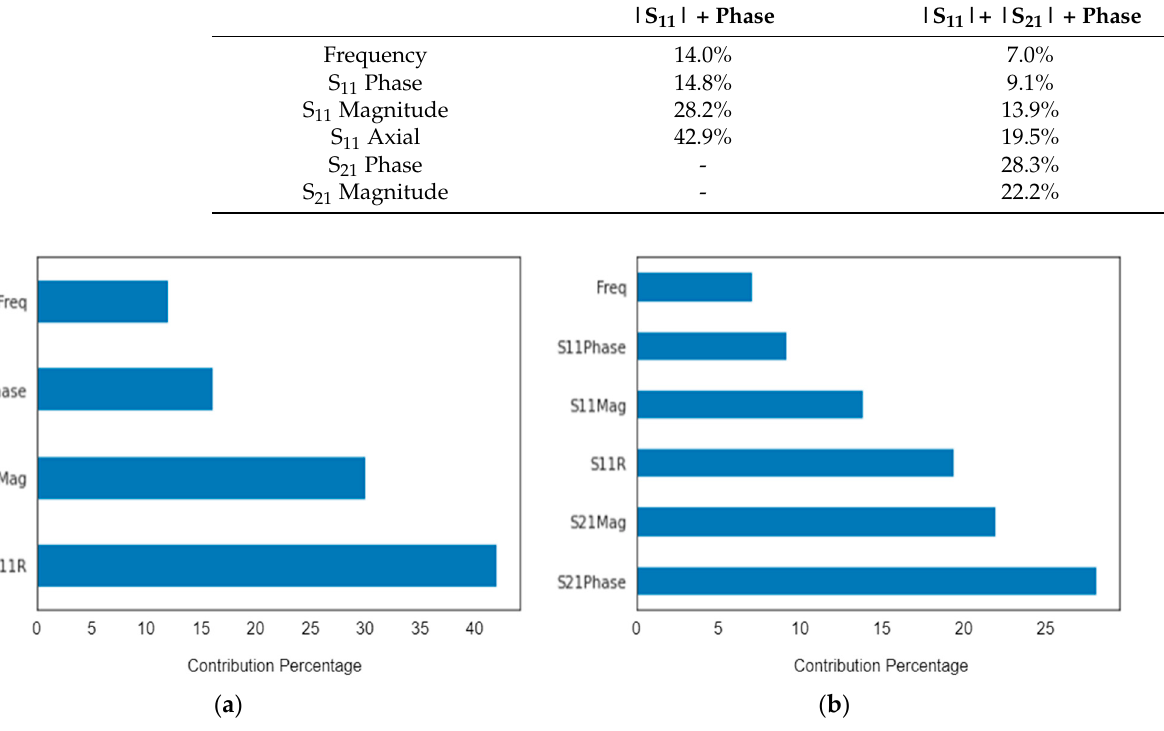
Figure 21. Contribution of each feature parameter for the classification accuracy of the “CatBoost” algorithm ( a ) for first dataset of first scenario and ( b ) for second dataset of second scenario.